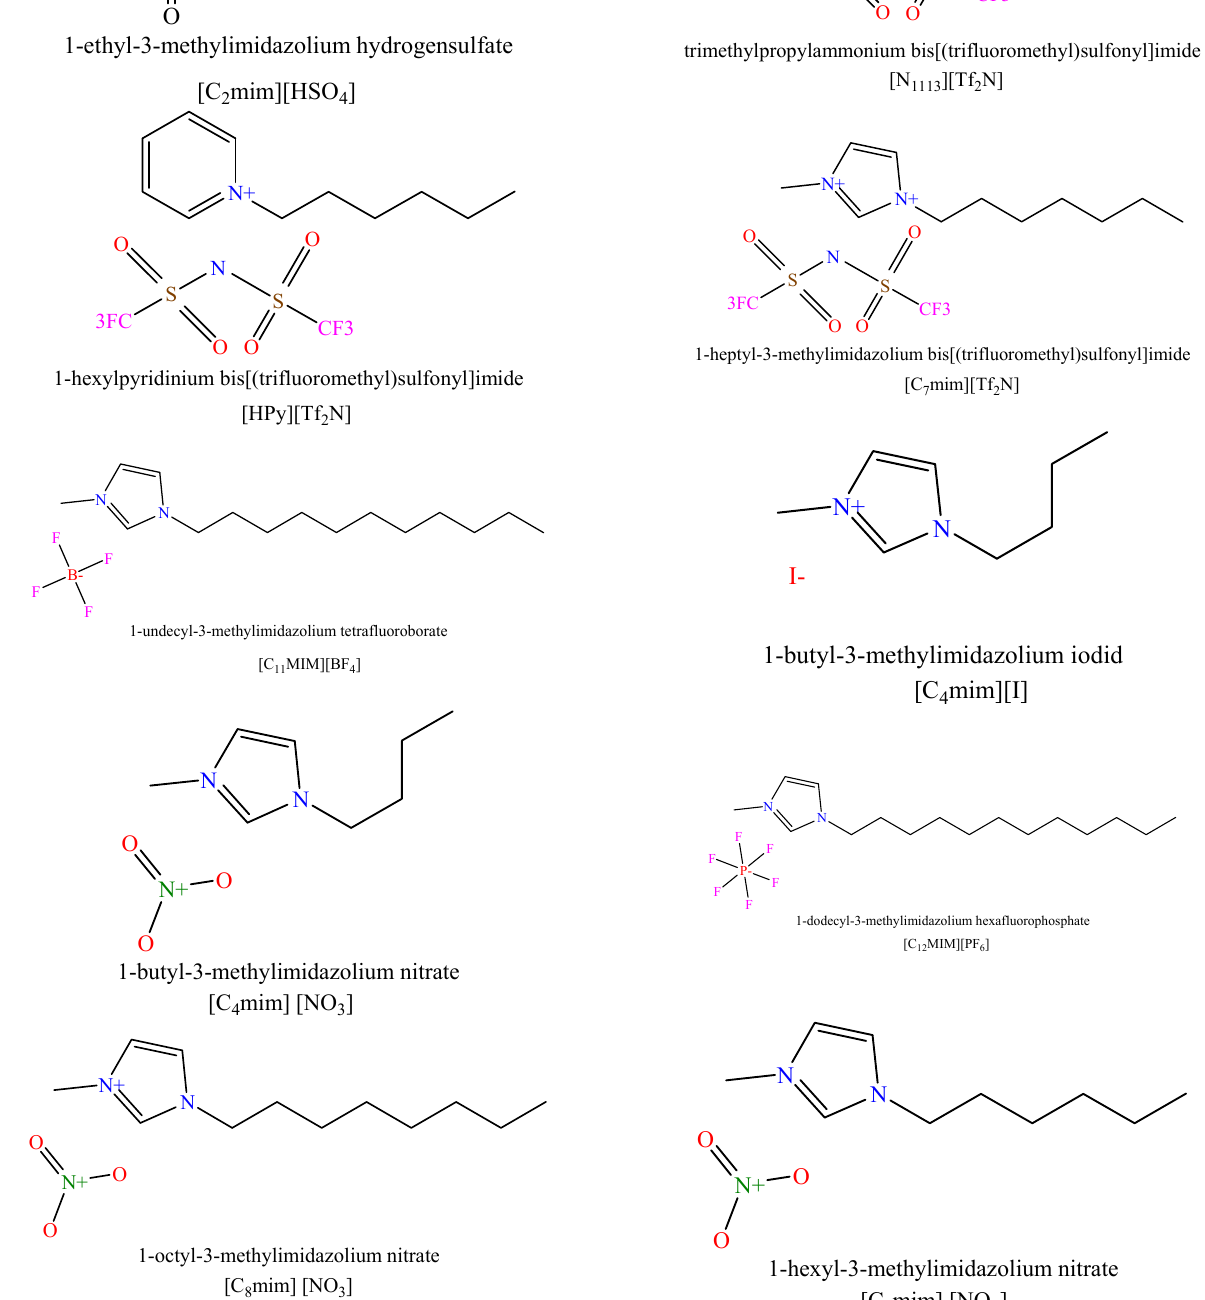
Figure 1. Chemical structure of ionic liquids (ILs) in this study.